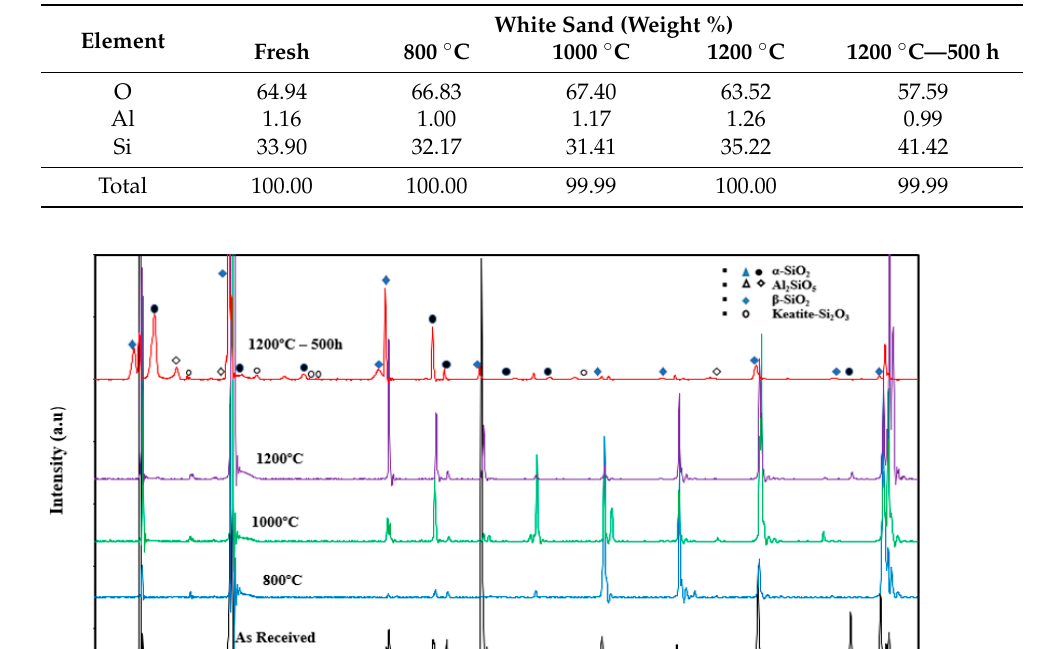
Figure 5. Spectral absorptance of the white sand samples (“as received” and after aging test) over the wavelength. Table 4. Elemental composition of white sand.